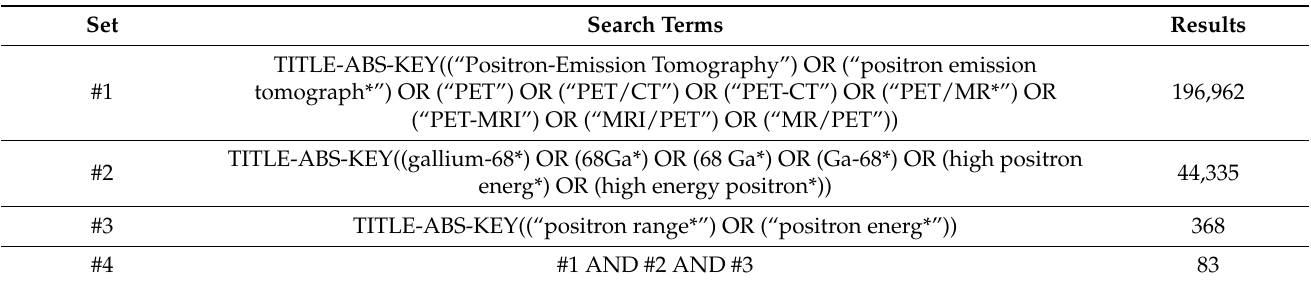
Table A2. The search query for positron range correction techniques in Scopus. In the column “Results”, the numbers of records are provided for the corresponding search terms from January 2010 until 1 August 2022.